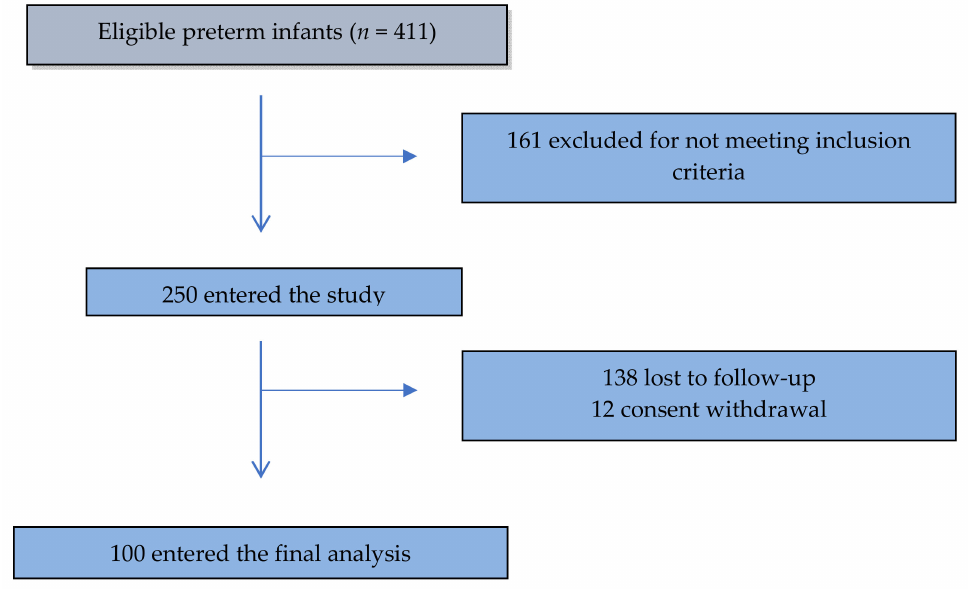
Figure 1. STROBE